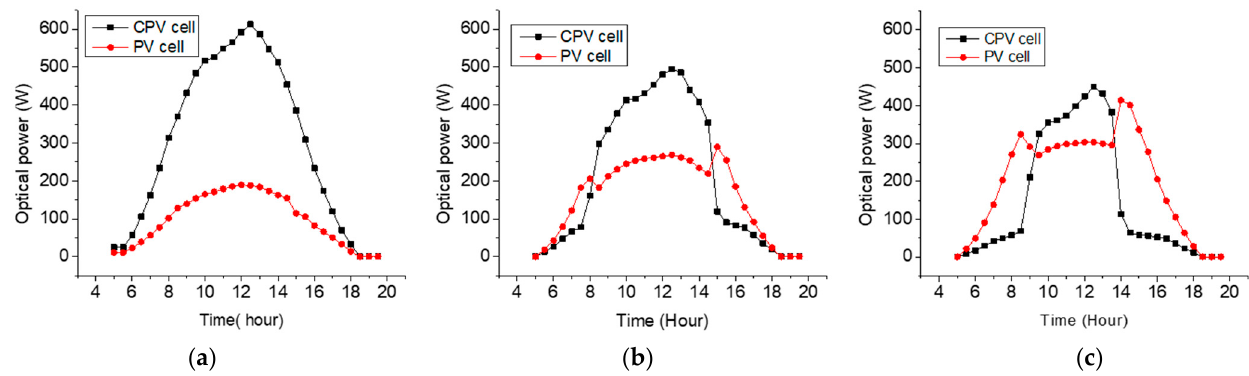
Figure 9. The optical powers of three different modules in Seoul: ( a ) module with C R = 2.25, ( b ) module with C R = 4, and ( c ) module with C R = 6.25.